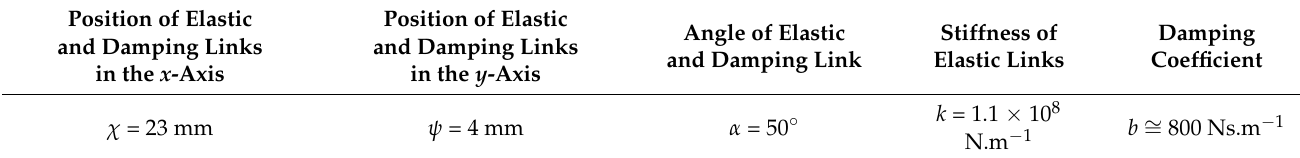
Table 3. Positions and parameters of elastic and damping links.